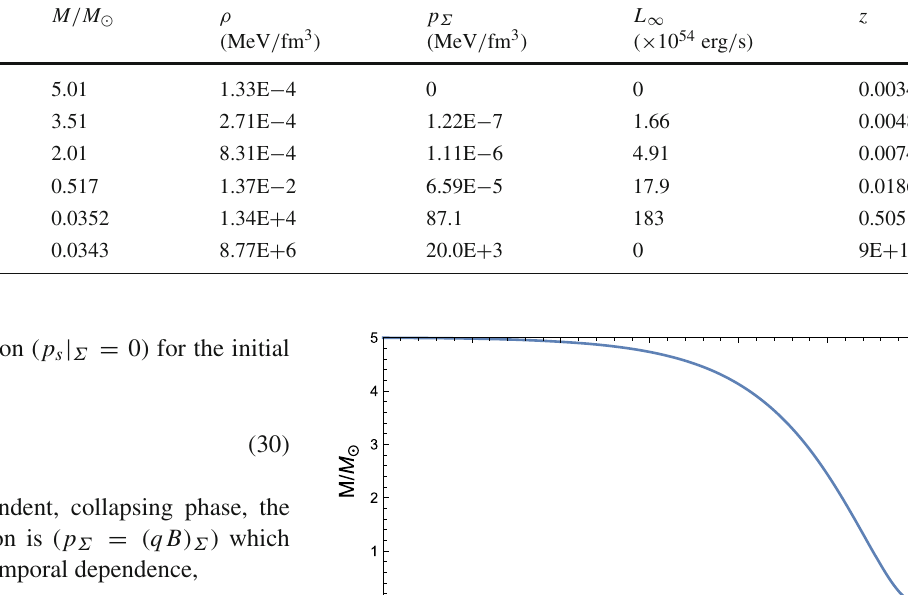
Table 1 Characteristics of shear-free, radiating fluid collapse following Maiti-type metric. ( f Lmax = 0 . 0004113 ; f BH = 0 . 00004696)